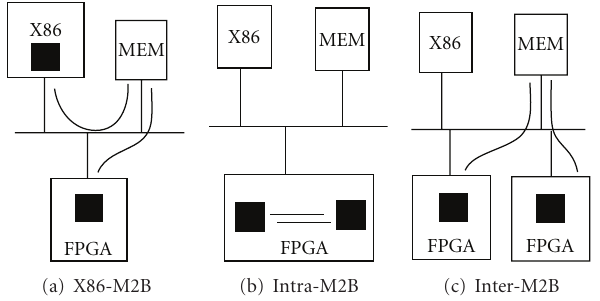
Figure 7: Di ff erent ways two MPI ranks can be mapped and